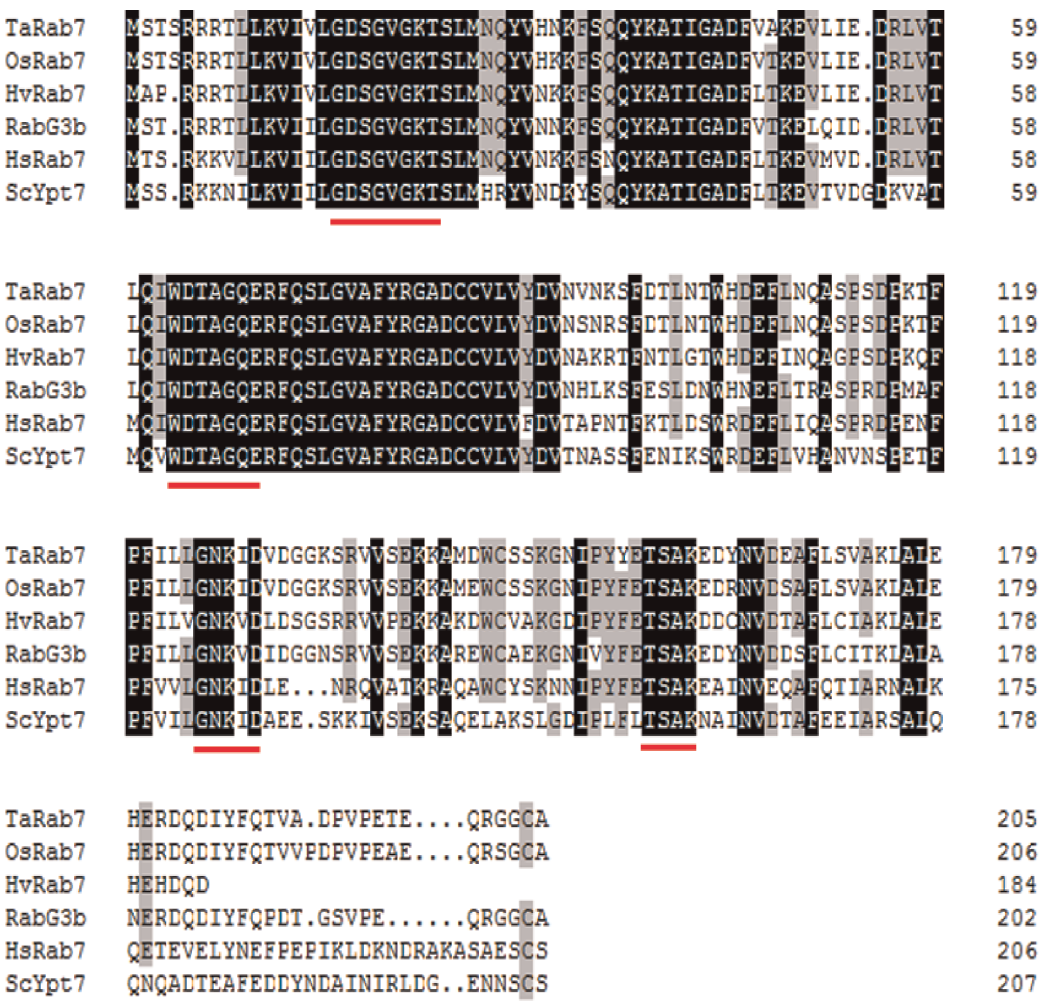
Figure 1. Alignment of the amino acid sequence of TaRab7 and selected Rab7 proteins. Alignment of the amino acid sequence of Triticum aestivum Rab7 ( TaRab7 ) with other Rab7 proteins from Oryza sativa ( OsRab7 ), Hordeum vulgare ( HvRab7 ), Arabidopsis ( RabG3b ), Homo sapiens ( HsRab7 ) and Saccharomyces cerevisiae ( ScYpt7 ). Sequences were aligned using DNAMAN. Identical residues in all organisms are shaded. Red underlines indicate sequence motifs involved in nucleotide binding and hydrolysis that are conserved in Rab GTPases.